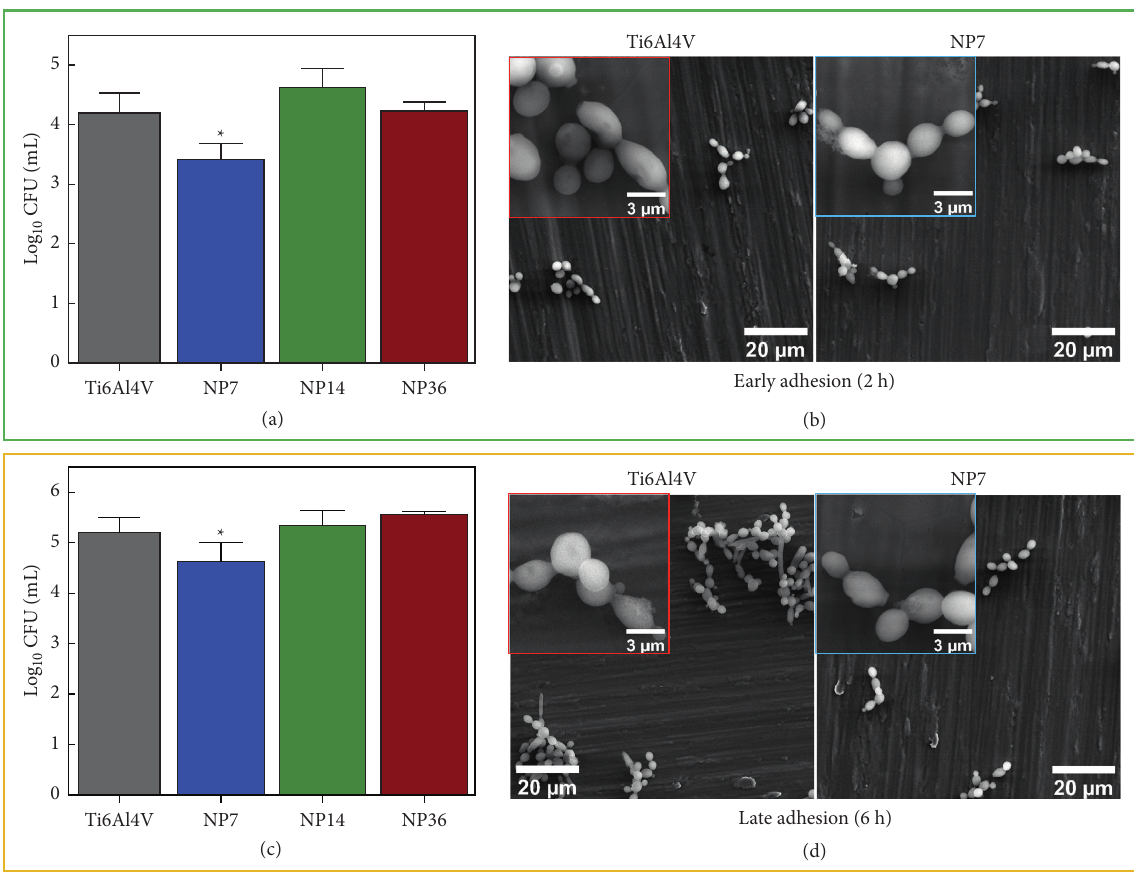
Figure 5: Antifungal analysis on the materials specimens. (a) C. albicans viability behavior after 2 h of growth. (b) Fungal morphology characterization on the control and NP7 surfaces at early adhesion phase. (c) C. albicans viability counts after 6h of incubation. (d) Fungal phenotype evaluation at the late adhesion stage. The symbol ∗ illustrates significant differences among the experimental